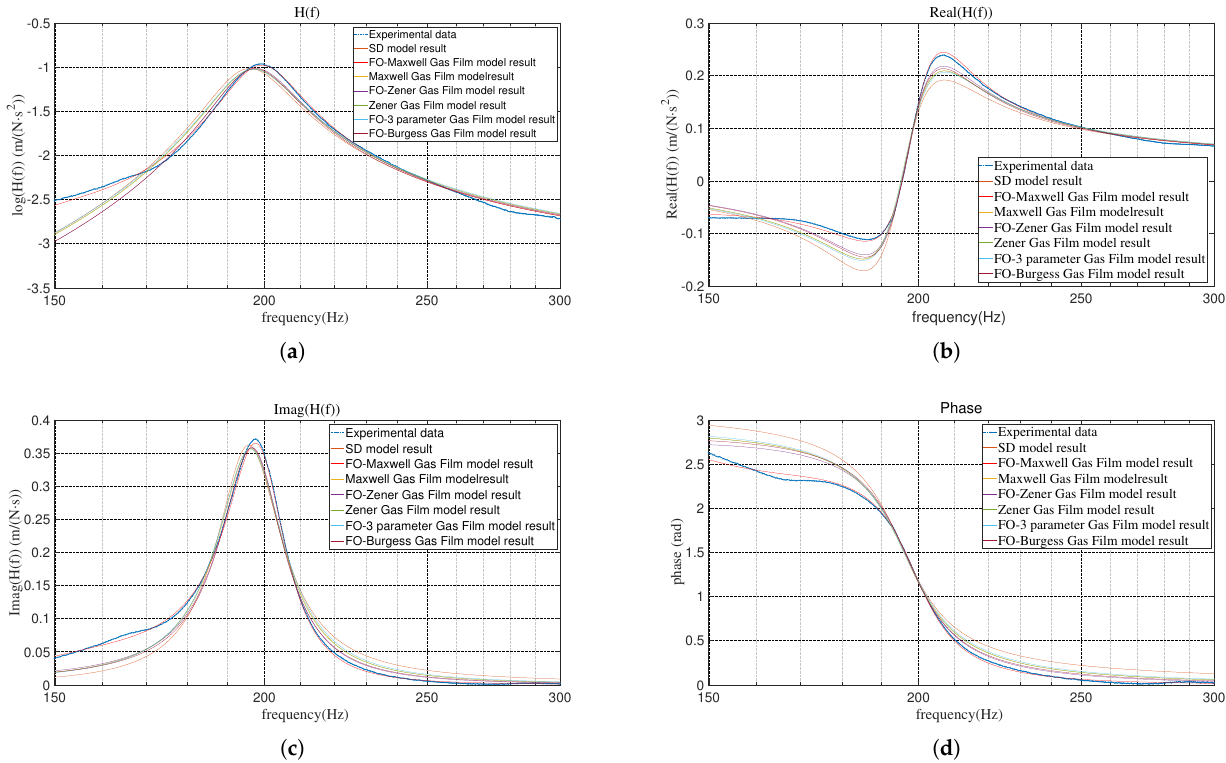
Figure 18. Comparison of the experimental results and model fitting results. ( a ) The logarithmic value of the transfer function H af shown in Equation (34). ( b ) Real part of H af . ( c ) Imaginary part of H af . ( d ) Phase change of H af